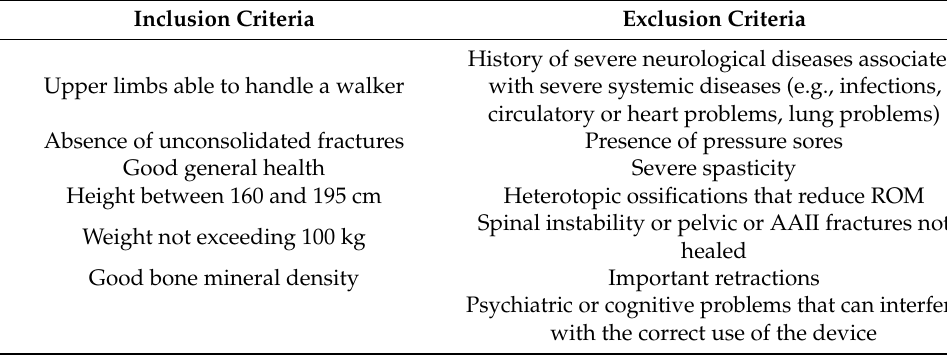
Table 1. Inclusion criteria for training with UAN.GO.